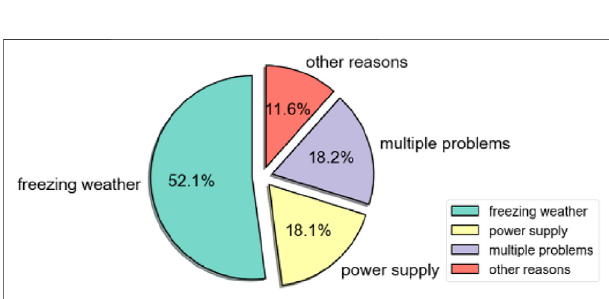
FIGURE7| Causeofthenaturalgasproductiondeclinefrom2021/2/14 9:00 a.m. to 2021/2/15 9:00 a.m. (measured by the natural gas production